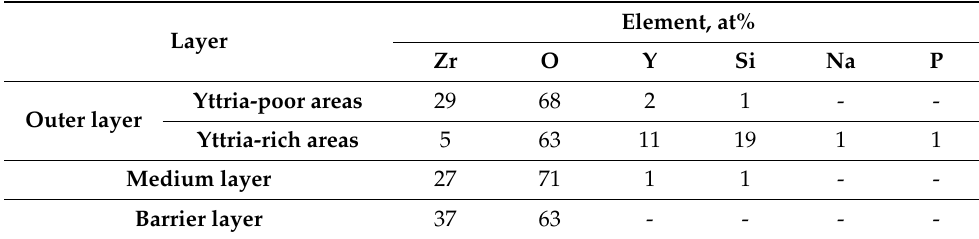
Figure 3. SEM images in the mode of backscattered electrons of the cross-sectional microstructure: PEO coatings formed at current densities 20 ( a ), 30 ( b ), and 40 ( c ) A/dm 2 and their microstructures at the boundary of barrier and middle layers. 1—barrier layer, 2—middle layer, 3—outer layer. Table 2. EDX